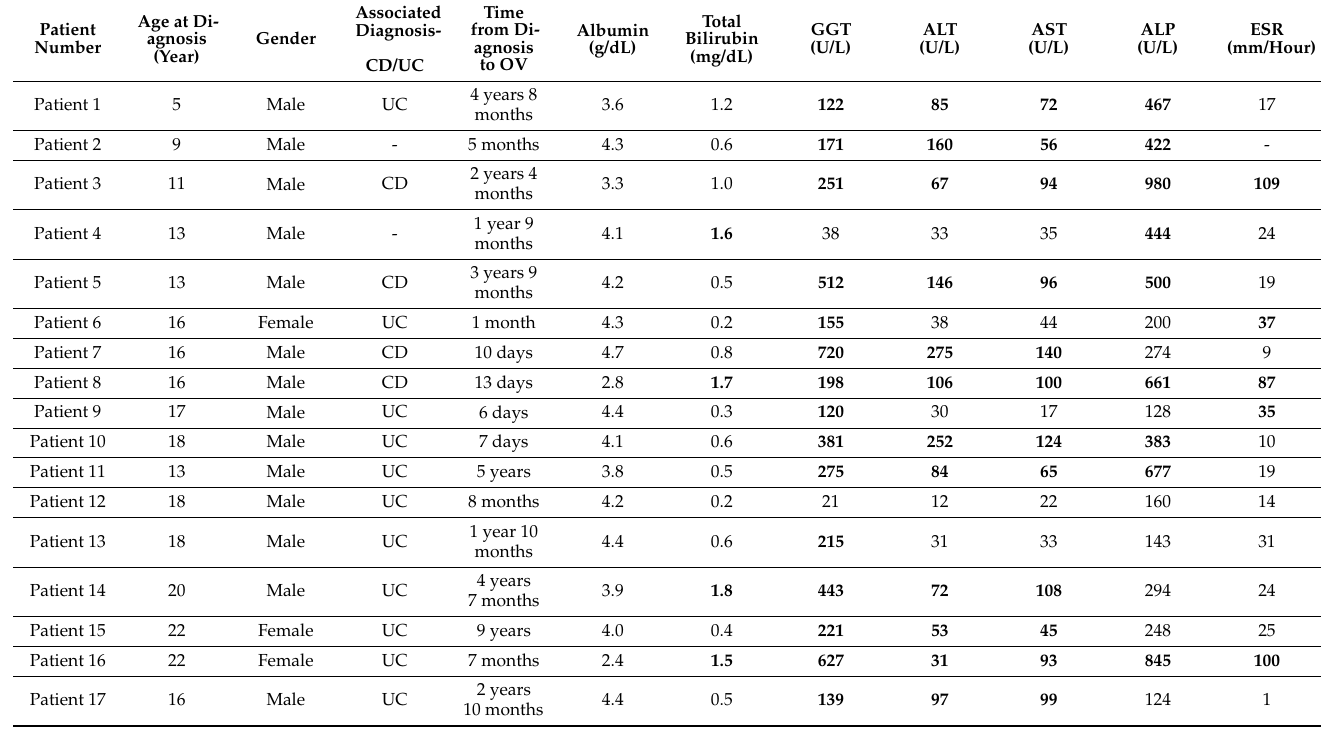
Table 1. Baseline characteristics of young patients with primary sclerosing cholangitis prior to initiation of oral vancomycin